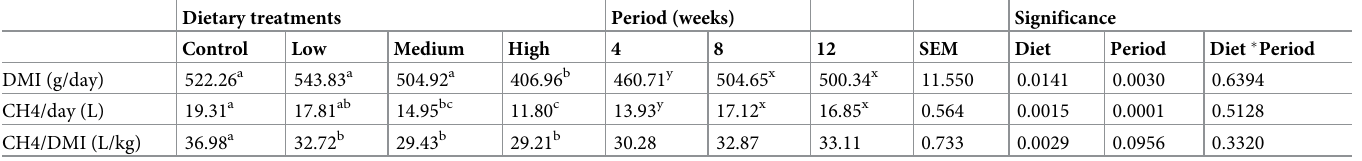
Table 5. Effects of increasing levels of lovastatin on methane emission from goats. Dietary